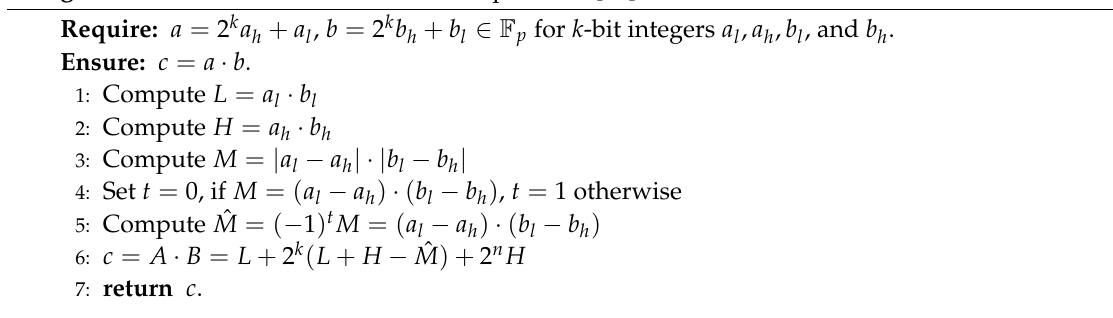
Algorithm 4: Subtractive Karatsuba multiplication